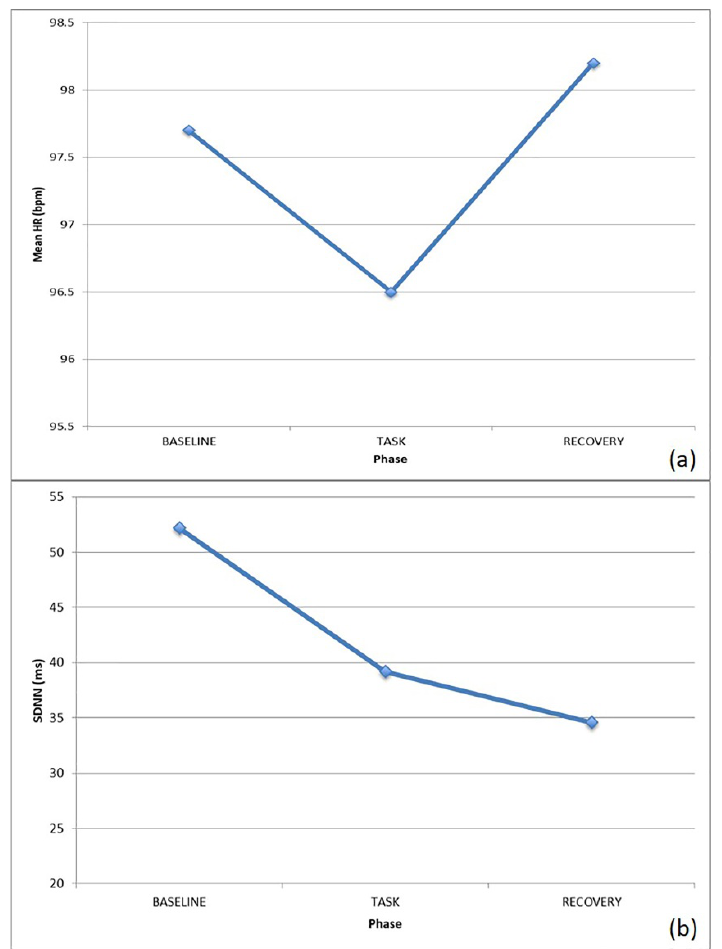
Figure 6. HR / HRV for B. during the various phases of the action on the represented: ( a ) HR, ( b ) SDNN.